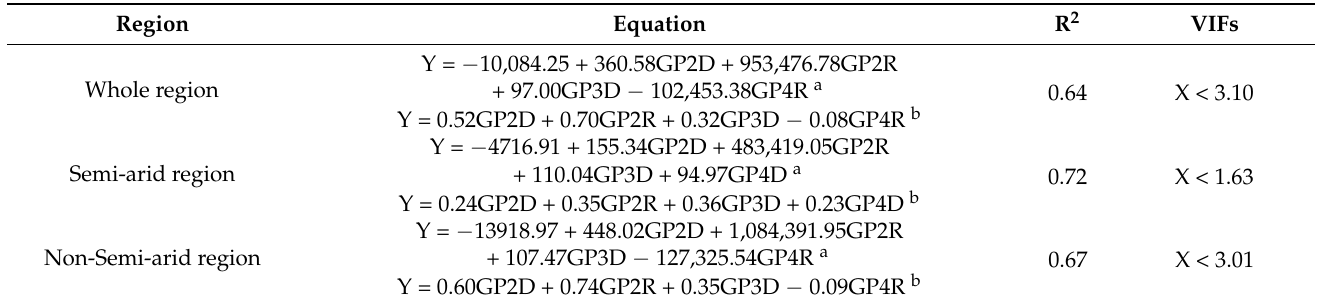
Table 2. Results from stepwise multiple linear regression between phenological metrics during all phenological phases and yield with data from 2008 to 2018. Region Equation R 2 VIFs Whole region